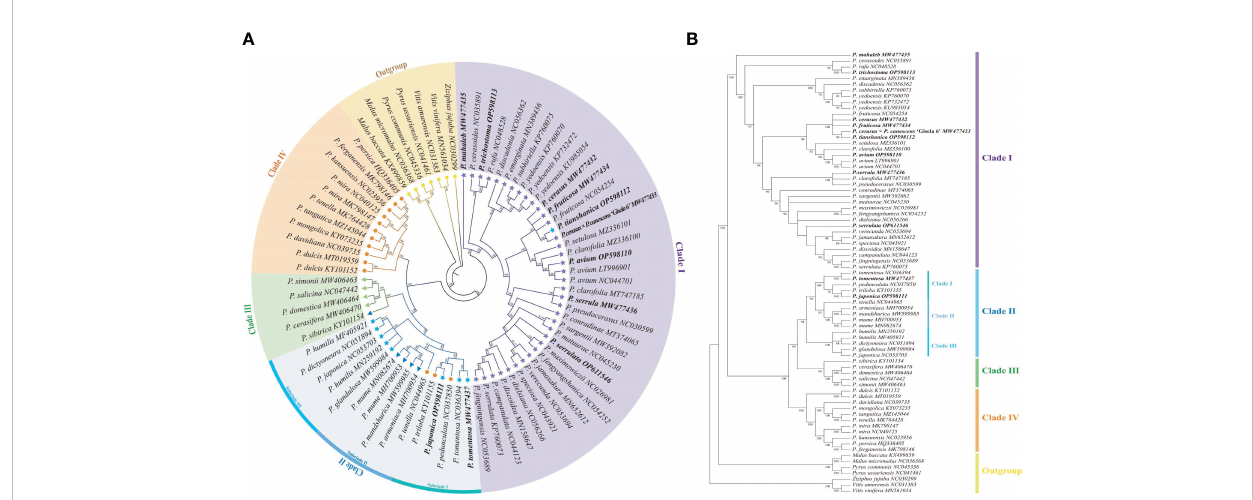
FIGURE 6 Phylogenetic tree reconstruction of 45 Cerasus species and 23 other Prunoideae species based on whole chloroplast genome sequences. (A) Phylogenetic tree reconstruction using the program Mrbayes of Geneious Prime v2022.0.2. Numbers above the lines represent the Bayesian inference posterior probability (percent). (B) Phylogenetic tree reconstruction using Maximum likelihood method of MEGA v11. Numbers below the lines represent the bootstrap support